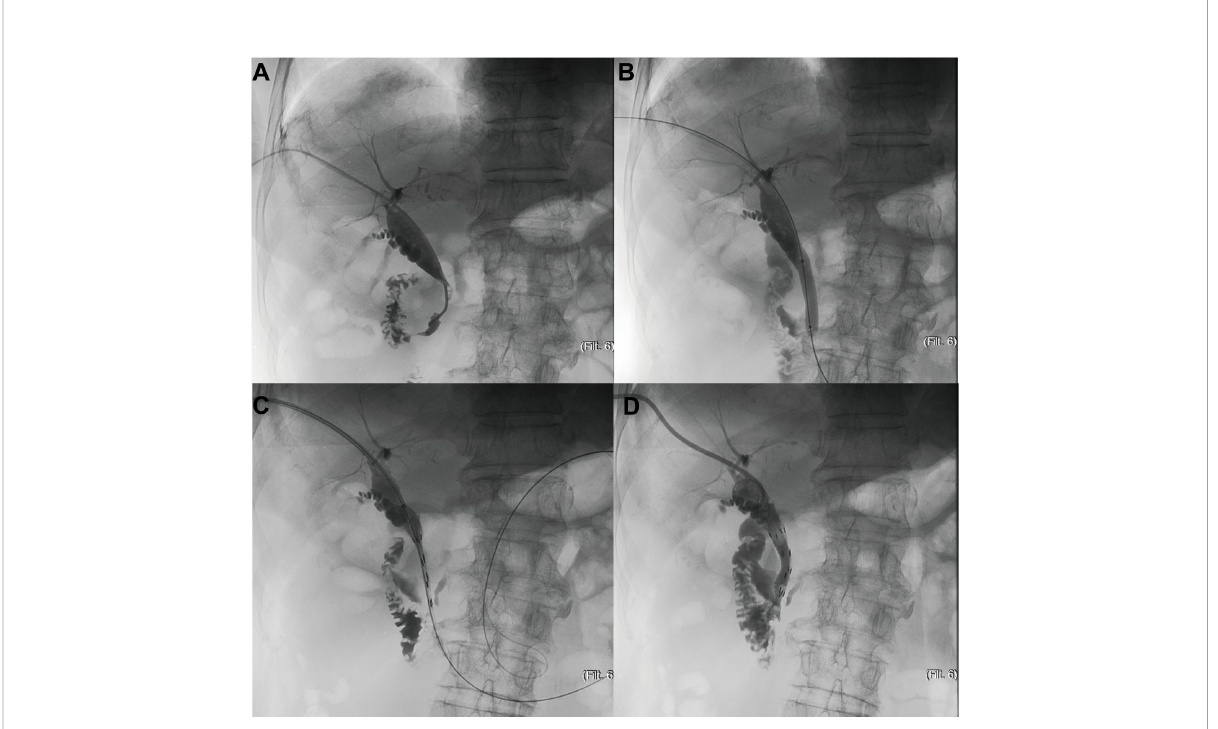
FIGURE 1 The schematic diagram of PTBS placement. (A) Con fi rmation of location and length of obstruction via cholangiography catheter (B) Dilation of passage with a balloon dilator catheter (C) Delivery of the outer 125 I seed-loaded stent into the targeted location of lesion (D) Deployment of the inner stent to cover the outer